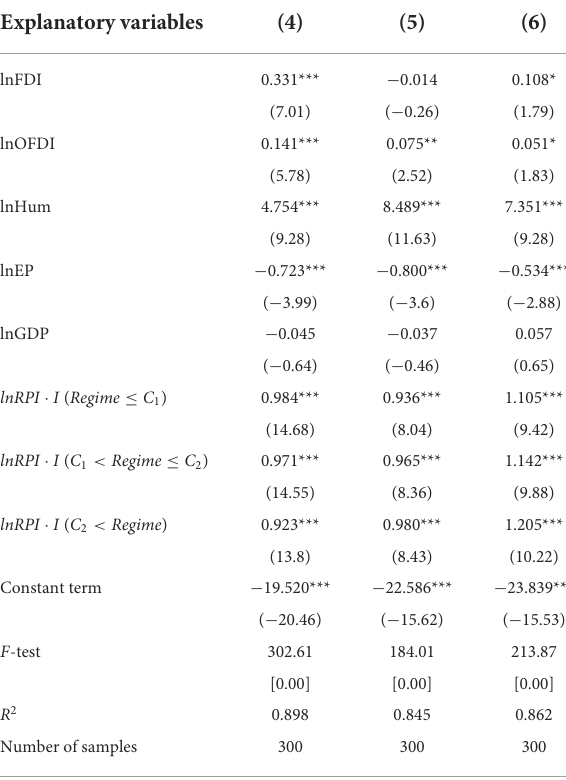
TABLE 5 Threshold results with Rci as an independent variable. TABLE 6 Threshold results with Rpi as the core explanatory